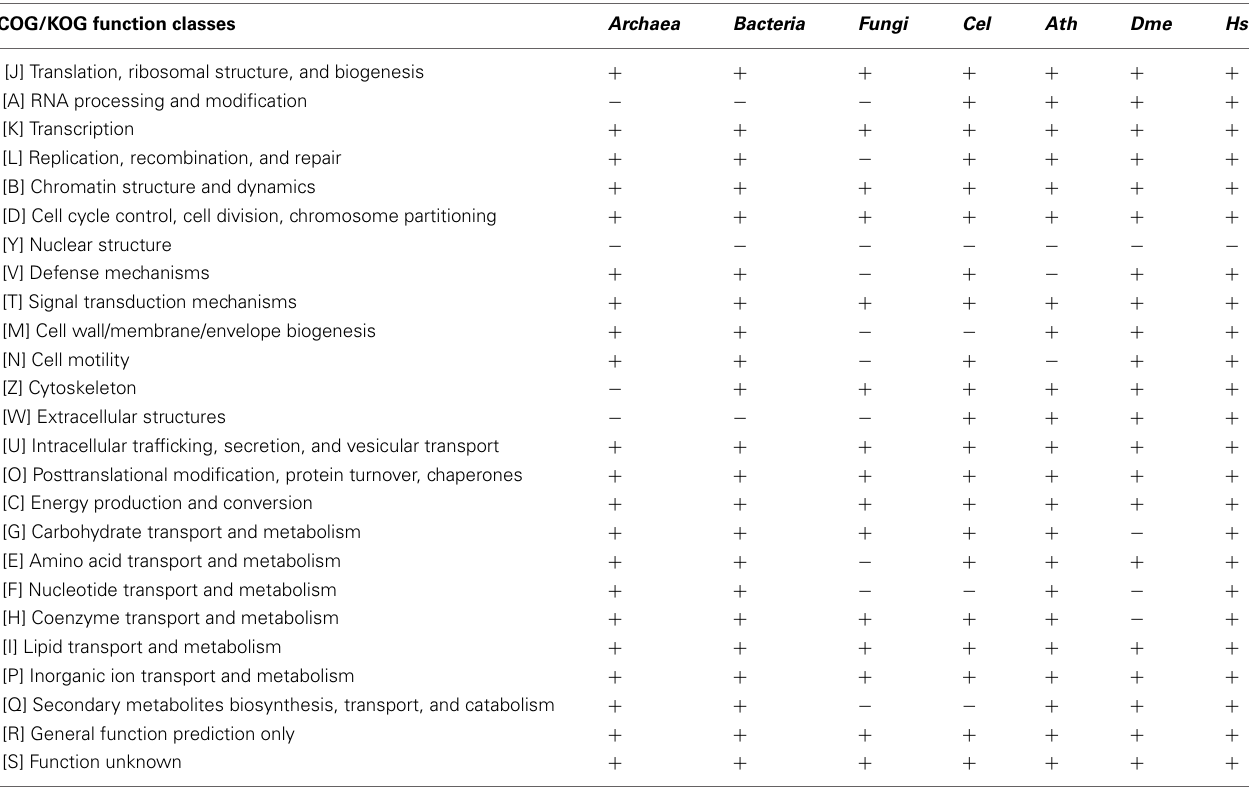
Table 1 | Function characterization of small proteins in COG/KOG database.